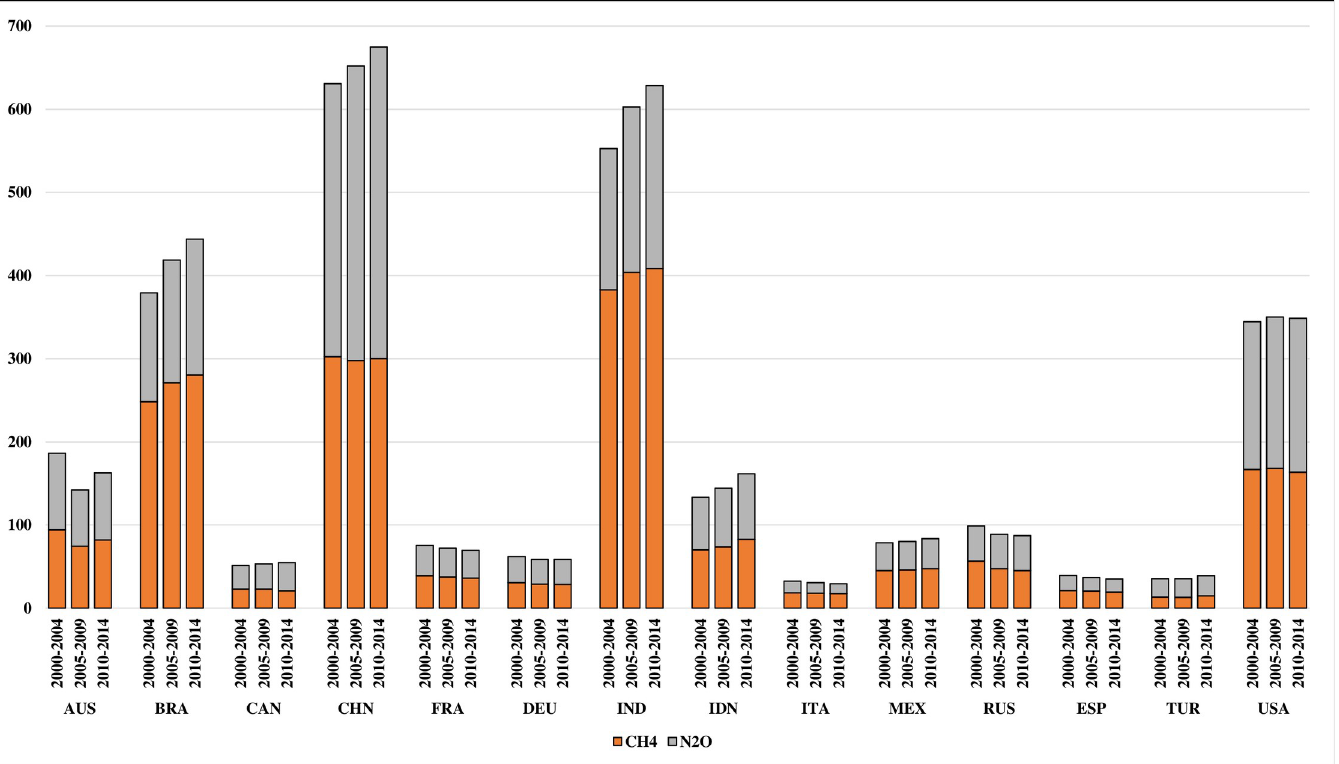
Fig 2. Average agricultural emissions of methane (CH 4 ) and nitrous oxide (N 2 O) in the selected countries in megatonnes of carbon dioxide equivalent (CO 2 eq). Source: Authors’ compilation based on the FAO Emissions Database, http://www.fao.org/faostat/en/#data/GT.